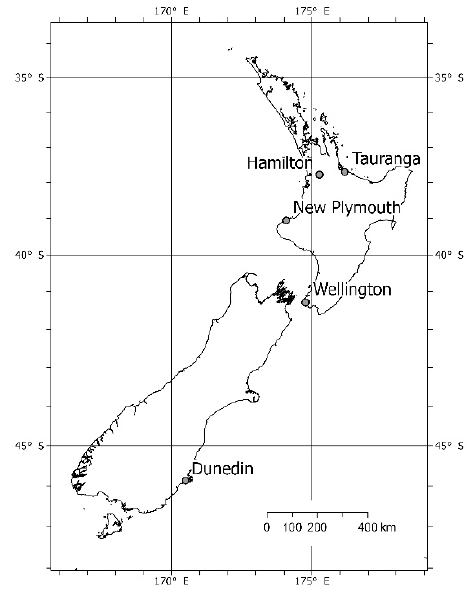
Figure 1. Map of New Zealand showing cities surveyed.